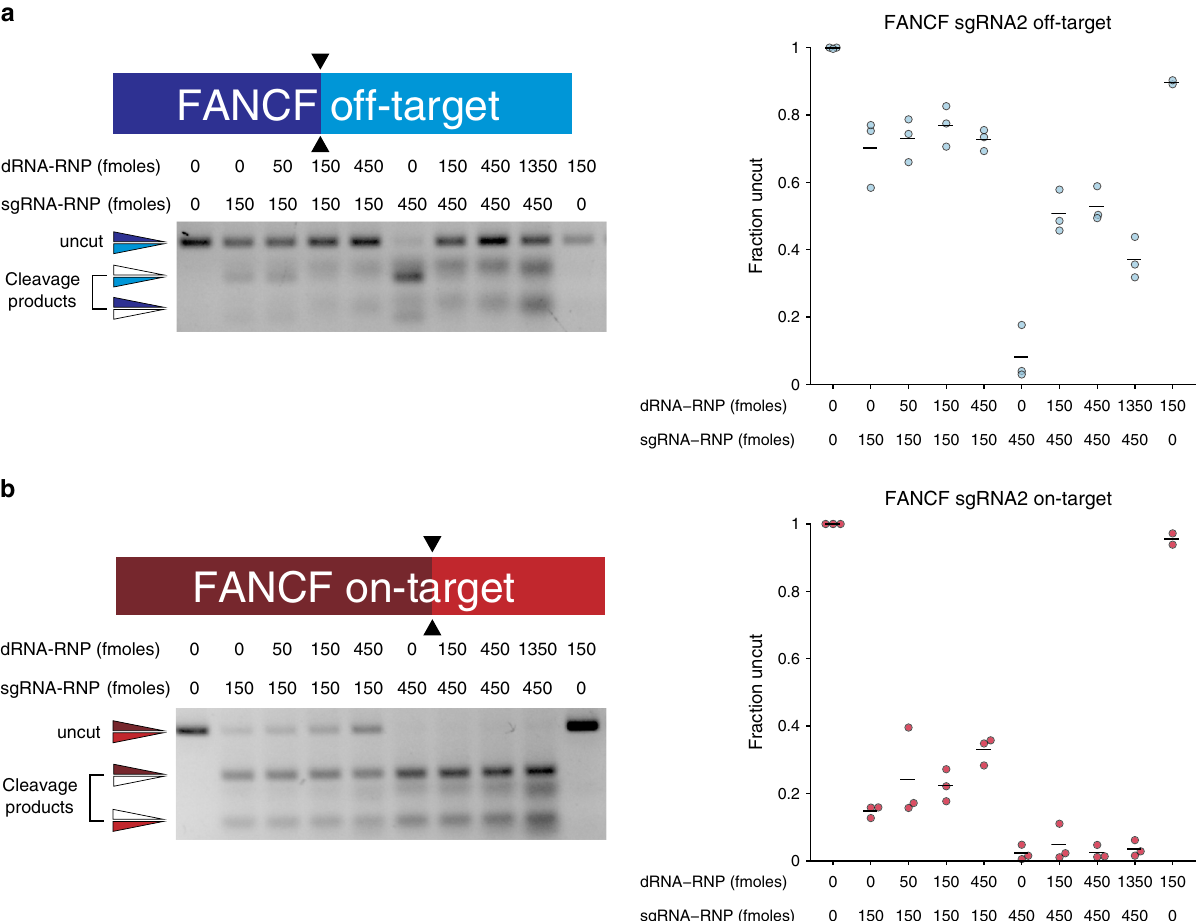
Fig. 2 dRNAs suppress off-target editing by competing with sgRNAs for off-target sites. Representative gels of in vitro cleavage of PCR products containing either a FANCF -sgRNA2 OT1 or b the FANCF -sgRNA2 on-target site with either 150 or 450 fmoles of Cas9 FANCF -sgRNA2 RNP in the presence of variable amounts of the Cas9 FANCF- sgRNA2 OT1 dRNA1 complex. Fraction of uncut DNA determined by gel densitometry. Means of n = 3 replicates depicted by solid lines. For uncropped gels, see Supplementary Fig. 14. Source data are available in the Source Data fi